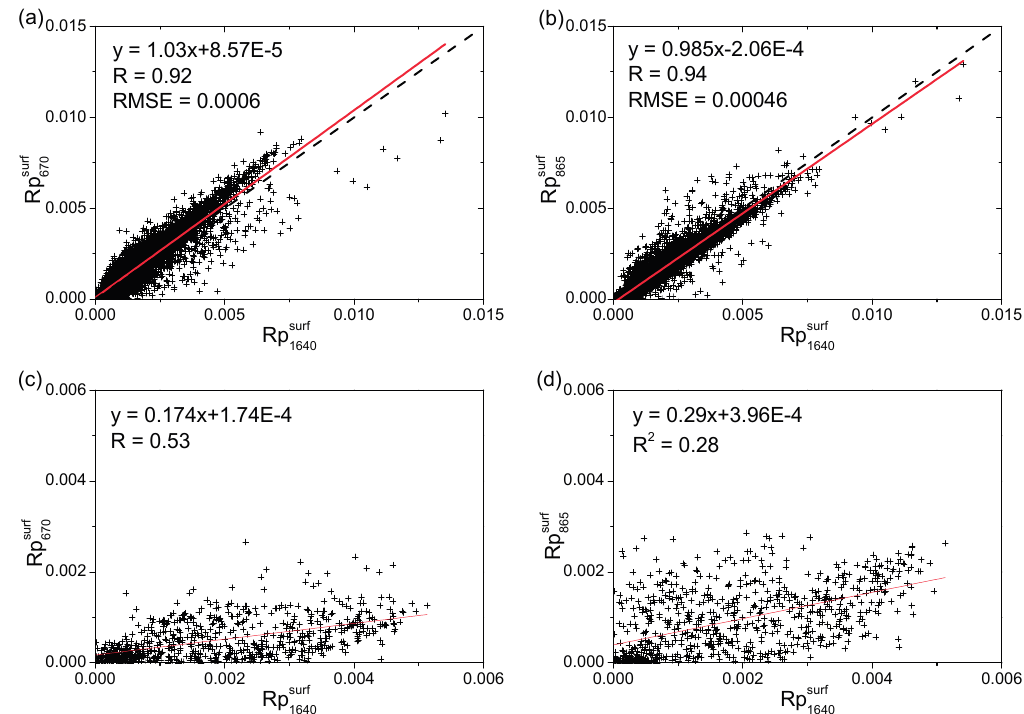
Figure 4. Scatter plots of polarized surface reflectance at 670 and 865 nm against 1640 nm, respectively, based on 165 scans during Flight 2. ( a , b ) Scattering angle smaller than 145°; ( c , d ) scattering angle larger than 145°. R is the correlation coefficient, and RMSE represents root-mean-square